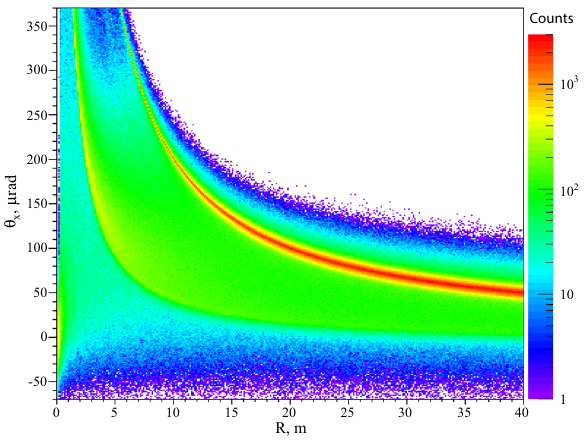
Fig. 7 The dependence of the number of positrons deflected on the angle θ x on the radius of curvature of the crystal for the (cid:2) 111 (cid:3) crystal orientation with respect to impinging